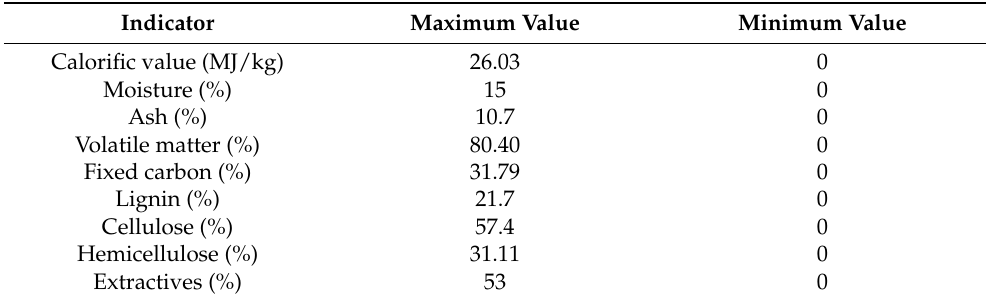
Table 4. Values of the indicators.